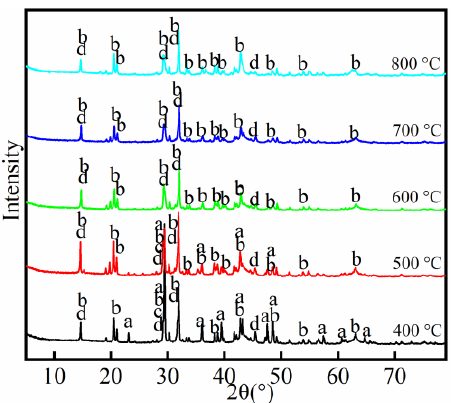
Figure 11. XRD patterns of recovered CaMgAl-LDOs at different reaction temperatures between 400 °C and 800 °C. ( a ) CaCO 3 ; ( b ) CaCl 2 ·2H 2 O; ( c ) Mg 0.03 Ca 0.97 (CO 3 ); ( d ) MgCl 2 .